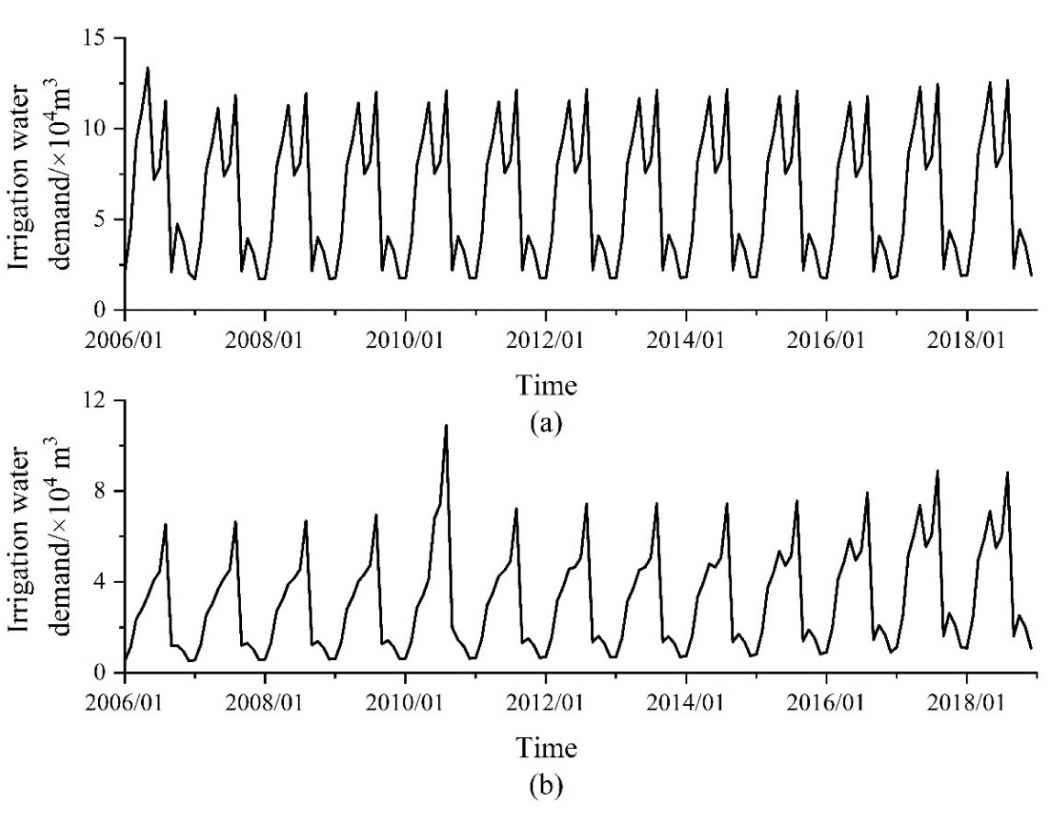
Figure 6. Variation of well irrigation water amount in Puyang during the period of 2006–2018: ( a ) The northern region; ( b ) The southern